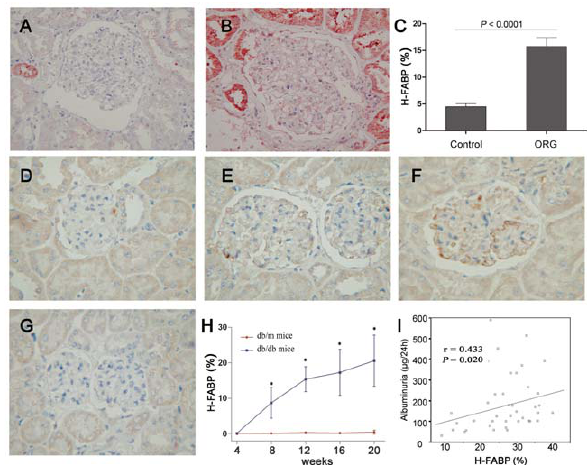
Figure 1. H-FABP in the glomeruli of patients with ORG and in db/db mice. A–C: H-FABP immunostaining in normal (A) and ORG- affected (B) glomerulus. It was shown that the expression of H-FABP was significantly higher in patients with ORG than in controls (C, P , 0.0001). D–H: Mouse H-FABP expression from 8 week db/db (D), 12 week db/db (E), 20 week db/db (F) and 20 week db/m control (G) mice. The percentage of the H-FABP-positive area in the glomeruli increased with age in db/db mice and was significantly higher than in db/m mice (H). I: Correlation of H-FABP expression with the albuminuria level, Pearson’s correlation test. Data are presented as the mean 6